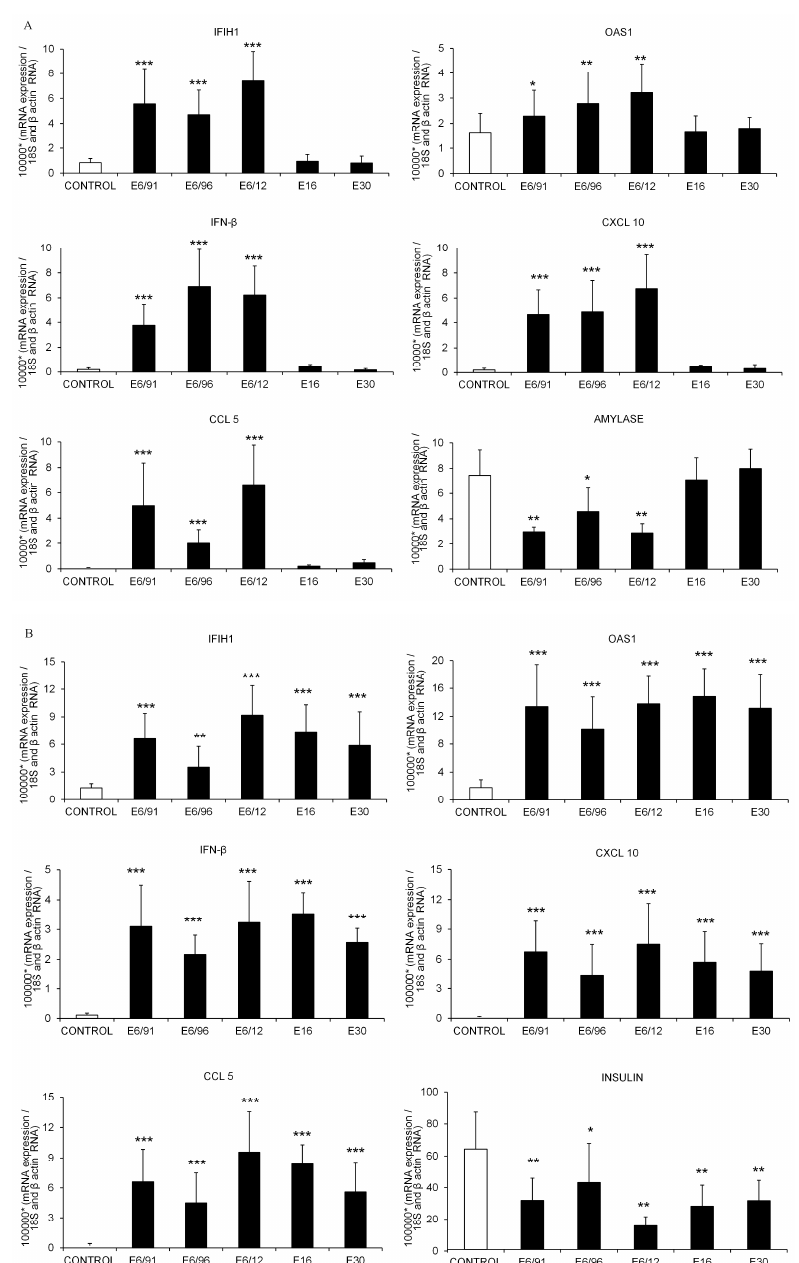
Figure 7. Expression of genes related to virus recognition, antiviral response and amylase in mock-infected and virus-infected pancreatic acinar cells ( A ); Expression of genes related to virus recognition, antiviral response and islet hormone in mock-infected and virus-infected islets ( B ). Isolated human exocrine cell clusters and islets were mock ‐ treated or infected with clinical strains of E6/91, E6/96, E6/12, E16 and E30 for 72 h. mRNA expression of interferon induced with helicase C domain 1 (IF1H1); 2 ′ –5 ′‐ oligoadenylate synthetase 1 (OAS1); interferon ‐β (IFN ‐β ); chemokine (C–X–C motif) ligand 10 (CXCL10); chemokine (C–C motif) ligand 5 (CCL5); amylase and insulin were assayed by real time reverse transcription ‐ polymerase chain reaction (RT ‐ PCR) and normalized by the house keeping gene 18S and β -actin using ∆ C t method. Gene expression levels are presented as mRNA expression relative to the expression of the housekeeping gene (2 − ∆ C t ). The expression level of each gene in virus-infected cells was compared to the one measured in mock-infected cells (control) from the same donors. Data are presented as means ± SD and were based on observations from at least three donors. C t: cycle threshold. * p < 0.05, ** p < 0.01, *** p <